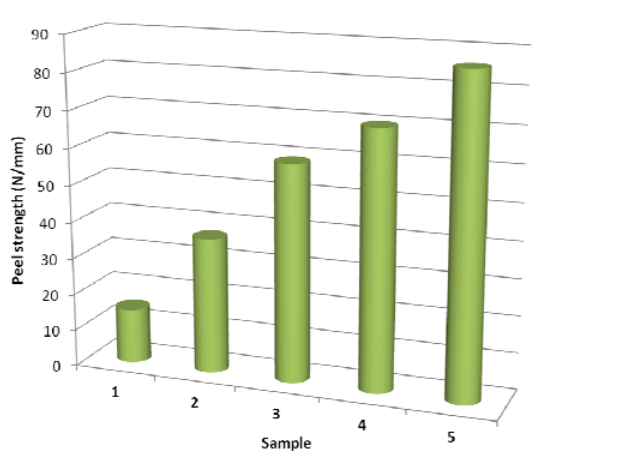
Figure 3. Peel strength vs. surface treatment; 1 - untreated LDPE; 2 - plasma-treated; 3 - AA grafted; 4 - triclosan coated; 5 - chlorhexidine coated.